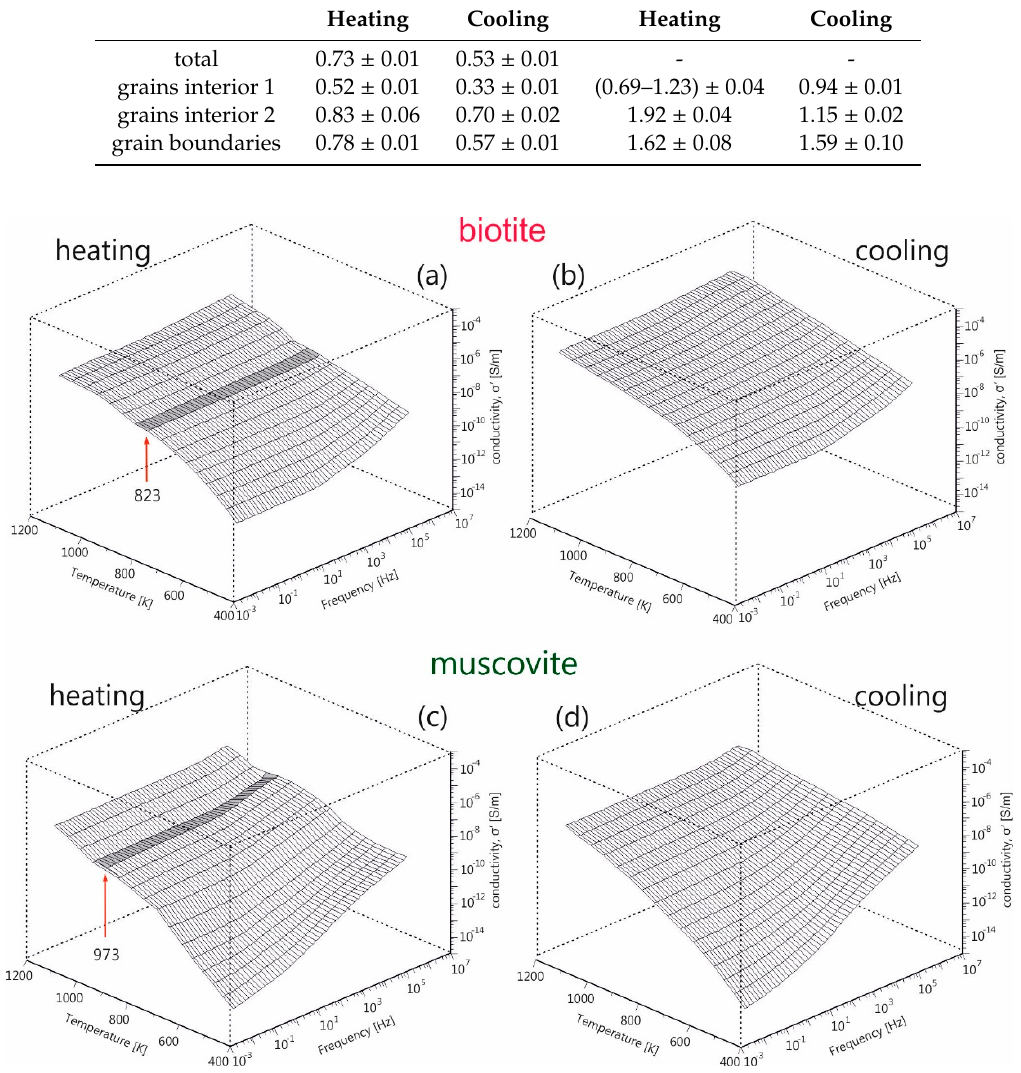
Figure 5. 3D-plane plots of real part of electrical ac-conductivity ( σ ’) as a function of frequency and temperature up to 1173K, for ( a , b ) biotite and ( c , d ) muscovite mica for both heating and cooling procedures. The dark areas around 823 K and 973 K for biotite and muscovite mica indicate the